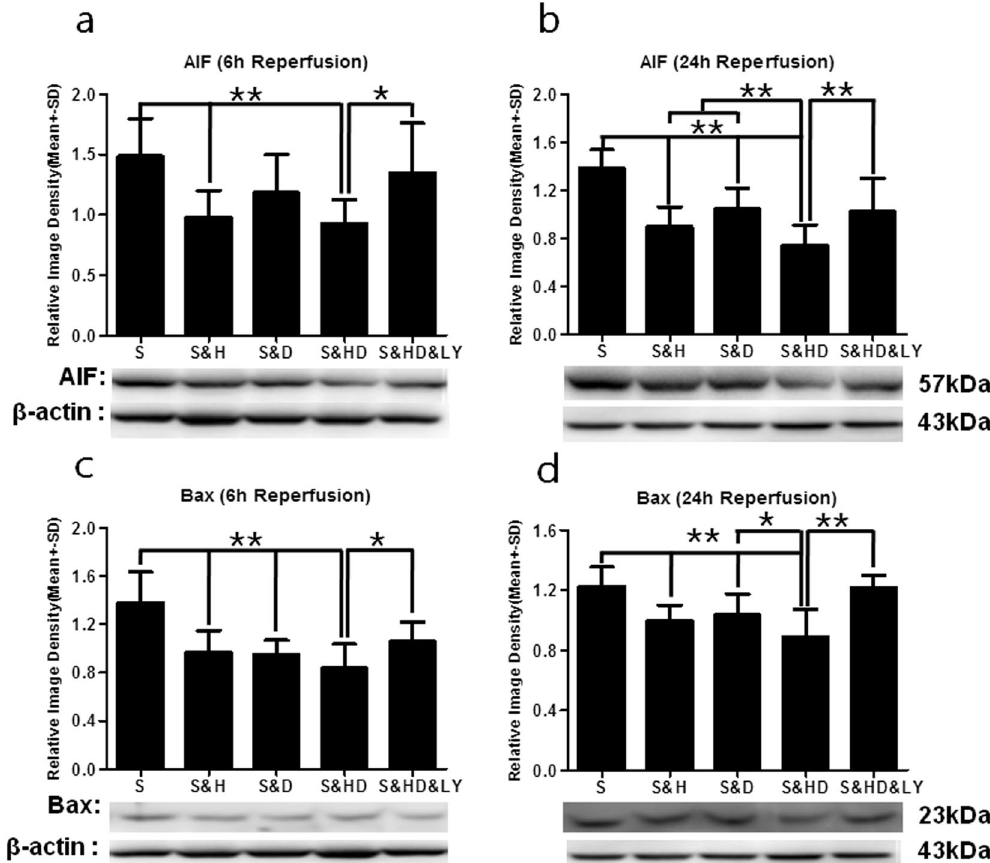
Figure 5. Reduction in pro-apoptotic protein expression with mild hypothermia and C + P combination therapy. ANOVA analyses indicated that there was a significant increase ( ** P < 0.01) in AIF levels after ischemic stroke (S) at both ( a ) 6 h (n = 6 per group) and ( b ) 24 h (n = 6 per group) of reperfusion. Ischemia- induced increase in AIF levels was significantly reversed ( ** P < 0.01) with combination therapy (S&HD) at both 6 h ( F (4,25) = 3.683) and 24 h ( F (4,25) = 12.009) of reperfusion. Monotherapy with either mild hypothermia (S&H) ( ** P < 0.01 at 6 h and 24 h) or C + P alone (S&D) ( ** P < 0.01 at 24 h) led to varying degrees of reduction in AIF expression. PI3K / Akt inhibitor (S&HD&LY) reversed the combination therapy-induced reduction in AIF levels at 6 h ( * P < 0.05) and 24 h ( ** P < 0.01). Similarly, there was a significant increase ( ** P < 0.01) in Bax levels after ischemic stroke (S) at both (c) 6 h (n = 6 per group) and ( d ) 24 h (n = 6 per group) of reperfusion. Although the expression of Bax was decreased by monotherapies (S&H and S&D) at 6 h ( F (4,25) = 7.165, ** P < 0.01) and 24 h ( F (4,25) = 8.510, ** P < 0.01), combination therapy (S&HD) further enhanced the decrease in Bax expression. PI3K / Akt inhibitor (S&HD&LY) reversed the combination therapy-induced reduction in Bax levels ( * P < 0.05 at 6 h; ** P < 0.01 at 24 h). Representative immunoblots are